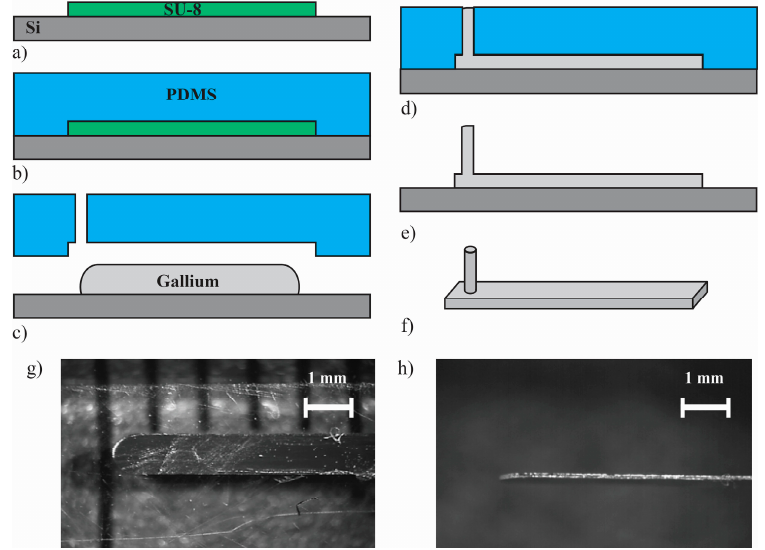
Figure A1. Images of micro-contact mold process. ( a ) SU-8 patterned lithographically on Si substrate; ( b ) PDMS poured over positive SU-8 mold, cured, then lifted free; ( c ) PDMS mold pressed against molten gallium on Si substrate; ( d ) Gallium was solidify by cooling with ice pack; ( e ) PDMS mold pulled off leaving gallium on substrate; ( f ) Free standing gallium ingot; ( g ) Top view of micromold-printed gallium ingot; ( h ) side view of gallium ingot.